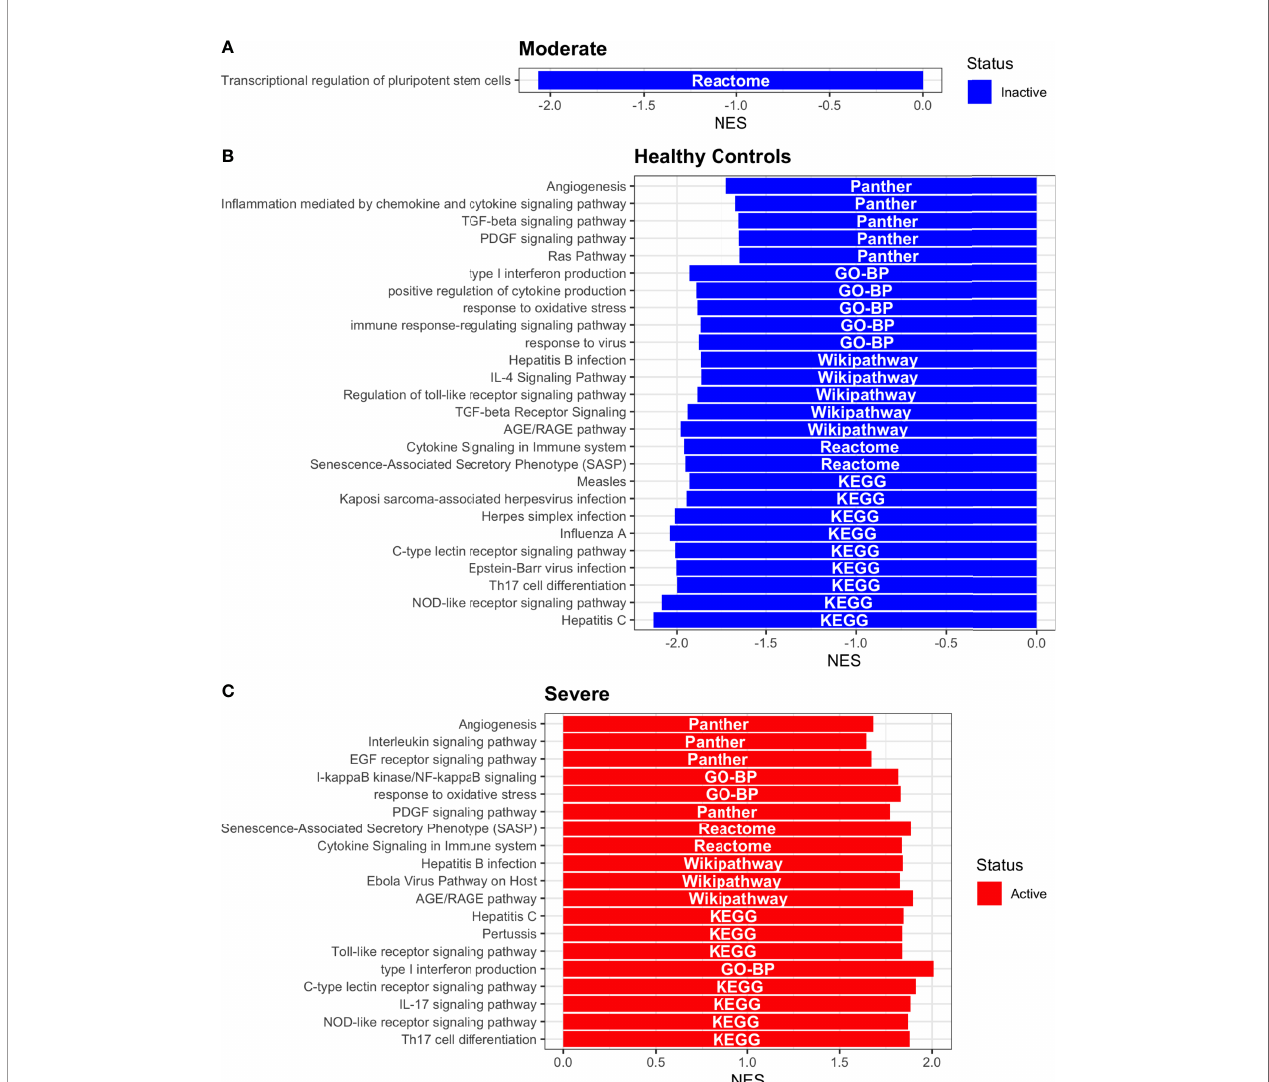
FIGURE 14 | Pathway Enrichment Analysis across various databases. Activity status of the TFs in a particular pathway found by DoROthEA across the disease severity in Neutrophils. (A) GSEA in moderate patients. (B) GSEA in healthy controls. (C) GSEA in severe patients. The normalized enrichment score (NES) value represents the activity status within the disease severity conditions, a positive value for active pathways (red), and a negative value for inactive pathways (blue). The dataset for every pathway (rows) is indicated inside the colored